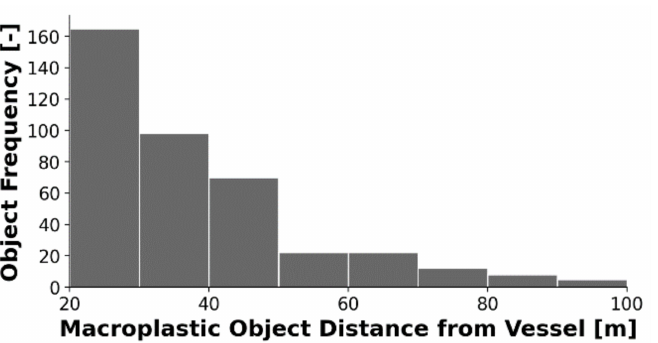
Figure 8. Histogram of validated macroplastic objects (Object Frequency) compared to distance from vessel. The distribution suggests a negative dependence of detection probability with distance.